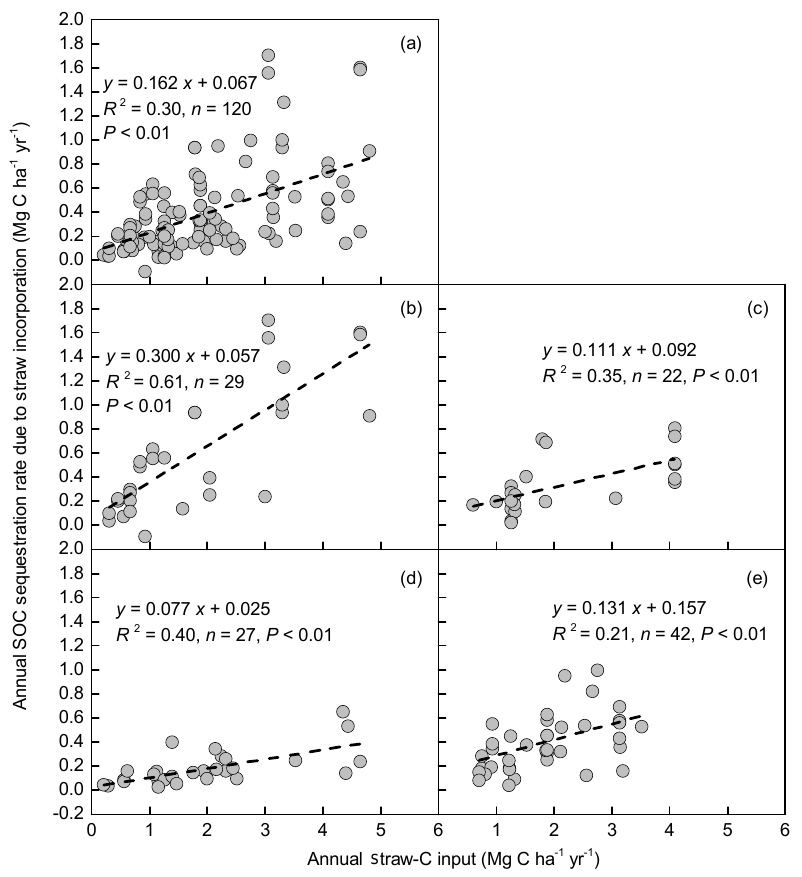
Figure 6. Relationships between annual soil organic carbon (SOC) sequestration rate and straw carbon input for (a) national scale, (b) northeast China, (c) north China, (d) northwest China and (e) south